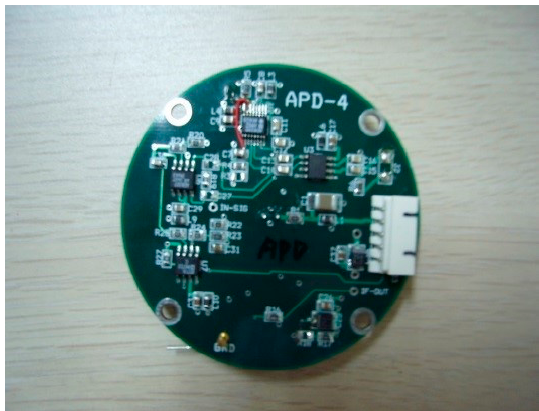
Figure 7. Measurement circuit for measuring the strength of radiation of reflective laser beam.